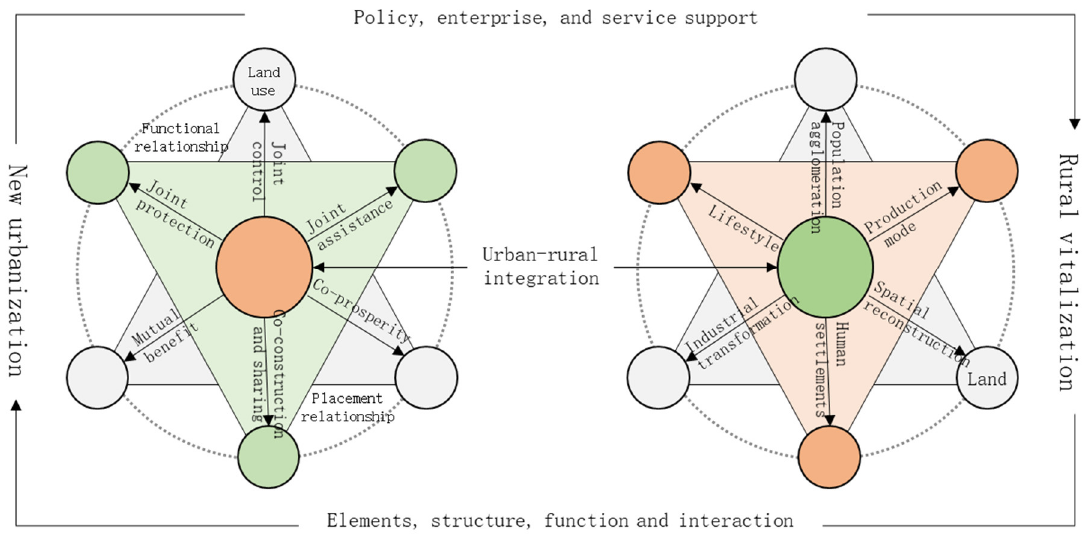
Figure 1. Schematic diagram of urban and rural elements in the metropolitan area.